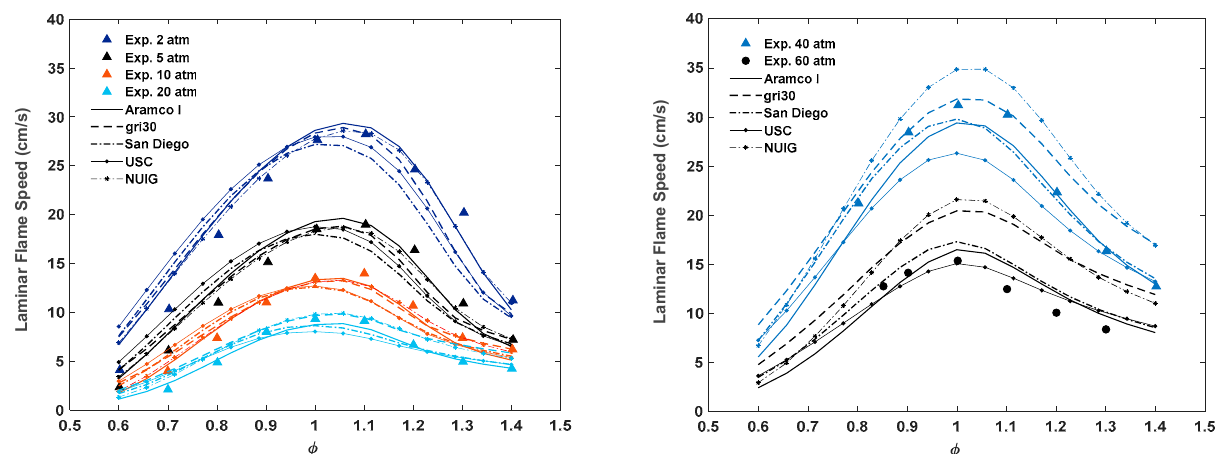
Figure 4. Comparison of laminar flame speed with the experimental data; left : CH 4 /air mixtures p = 2, 5, 10, 20, right : CH 4 /O 2 /He mixtures p = 40 and 60 atm as a function of equivalence ratio, T ini = 298 K [42] .